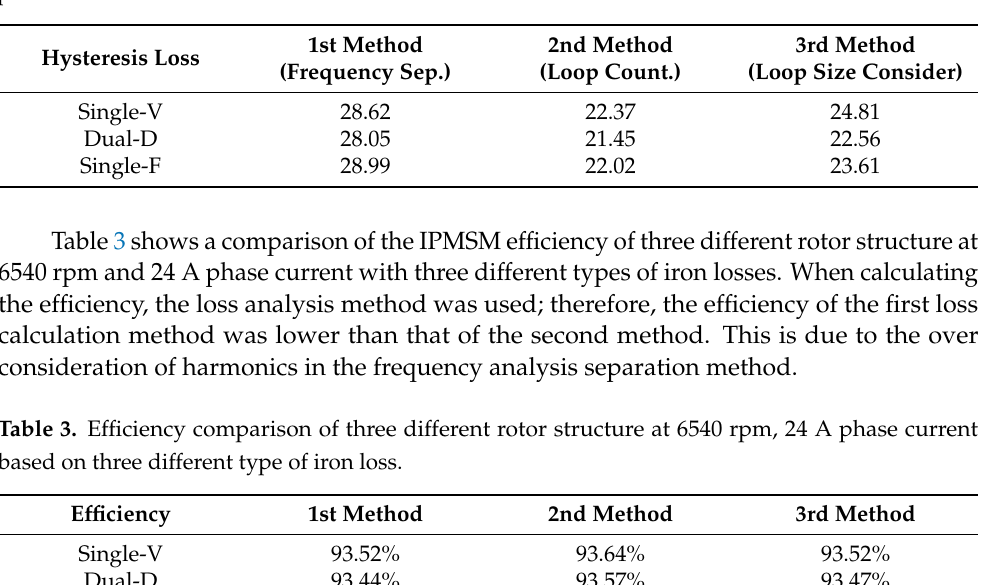
Table 2. Comparison of hysteresis losses of three different calculation methods at 6540 rpm, 24 A phase current.